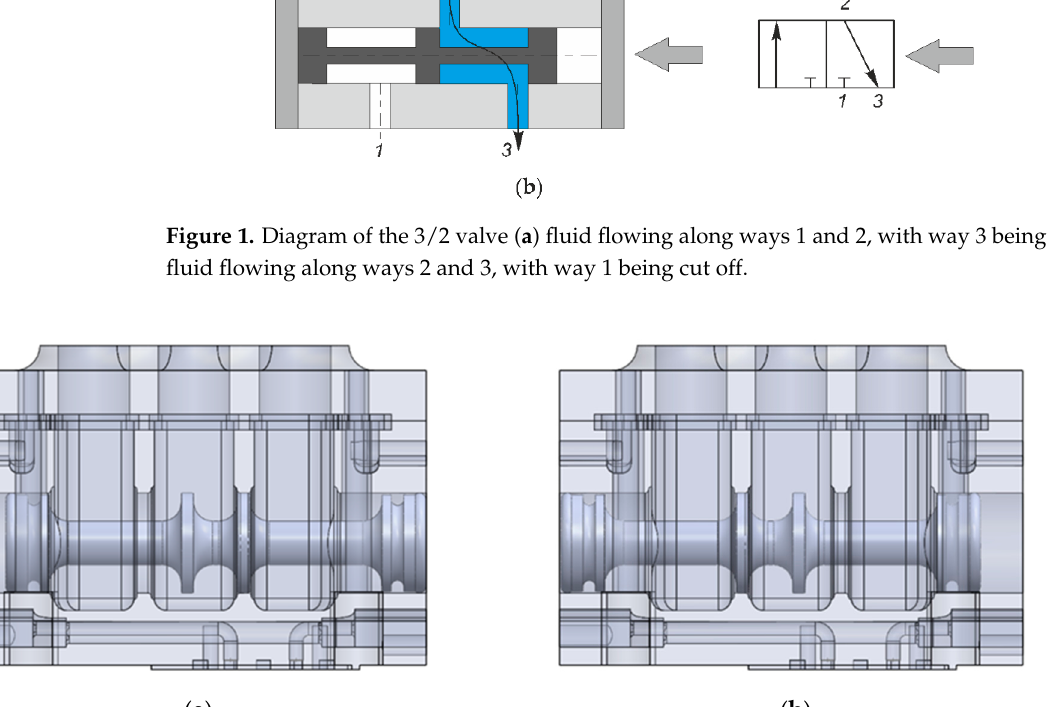
Figure 2. Solid model of the 3/2 valve, ( a ) fluid flowing along ways 1 and 2, with way 3 being cut off ( b ) fluid flowing along ways 2 and 3, with way 1 being cut off.